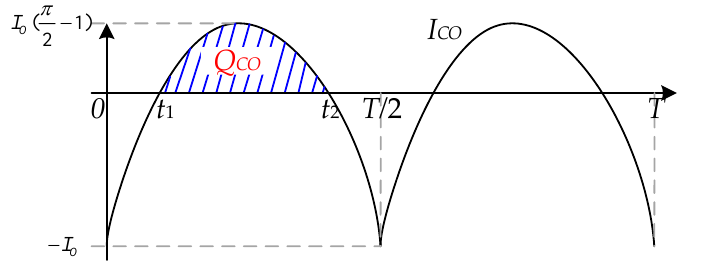
Figure 14. Current waveform of the output capacitor.